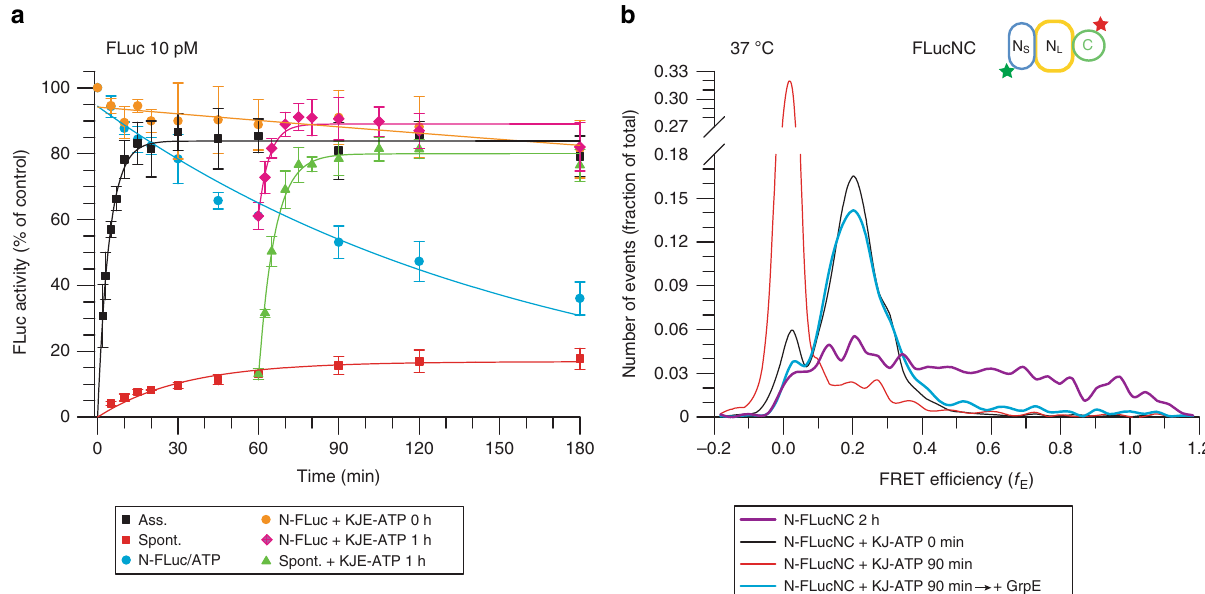
Fig. 8 KJE-accelerated folding maintains the native state of FLuc. a Luminescence activity of 10 pM FLuc was monitored at 37 o C, in the presence or absence of KJE-ATP. Time-dependent loss of FLuc activity was monitored by shifting N-FLuc from 25 o C to 37 o C (blue circles). 1 µ M DnaK, 0.33 µ M DnaJ and 1.5 µ M GrpE were included during temperature upshift of N-FLuc (orange circles), or added after 1 h incubation of N-FLuc at 37 o C (magenta diamonds), or after 1 h of spontaneous refolding from denaturant at 37 o C (green triangles). Assisted (Ass., black squares) and spontaneous (Spont., red squares) refolding are also shown. Error bars represent s.d. (n = 5). Ass., KJE-ATP-assisted; Spont., spontaneous folding. b N-FLucNC (10 pM) in folding buffer with PBT and ATP was shifted from 25 o C to 37 o C in the presence or absence of KJ. spFRET was recorded for 30 min after 2 h without chaperones. Upon heating in the presence of KJ-ATP, spFRET was recorded either immediately (0 min) or after 90 min. GrpE was added after 2 h to initiate refolding of FLuc from the DnaK-bound state. Representative measurements of three independent repeats are shown. Source data are provided as a Source Data fi